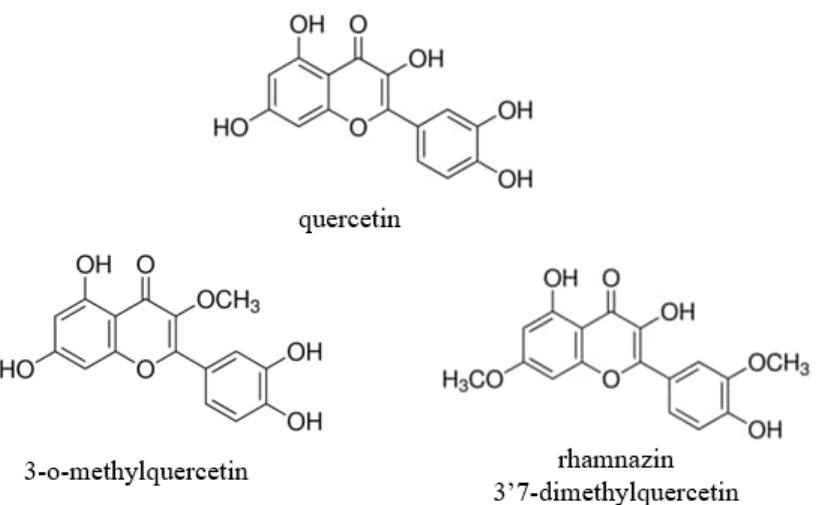
Figure 1. Structures of quercetin, 3-o-methylquercetin, and rhamnazin (3 ′ 7-dimethylquercetin). IPEC-J2 cells are intestinal columnar epithelial cells of mid-jejunum that are isolated from neonatal unsuckled piglets [23]. This noncancerous cell line more closely mimics the human physiology than other tumorigenic or transformed cell lines. Therefore, IPEC-J2 cells are a useful tool with which to investigate the status of the antioxidant defense system, inflammation, or epithelial integrity [24–27]. These intestinal cells express and produce different inflammatory interleukins (e.g., IL-6, IL-8), cytokines (e.g., granulocyte macrophage colony stimulating factor, TNF- α ), defensins, toll-like receptors, and mucins [28,29]. Culturing on 0.4 µ m pore-size membrane filters, these cells become polarized due to